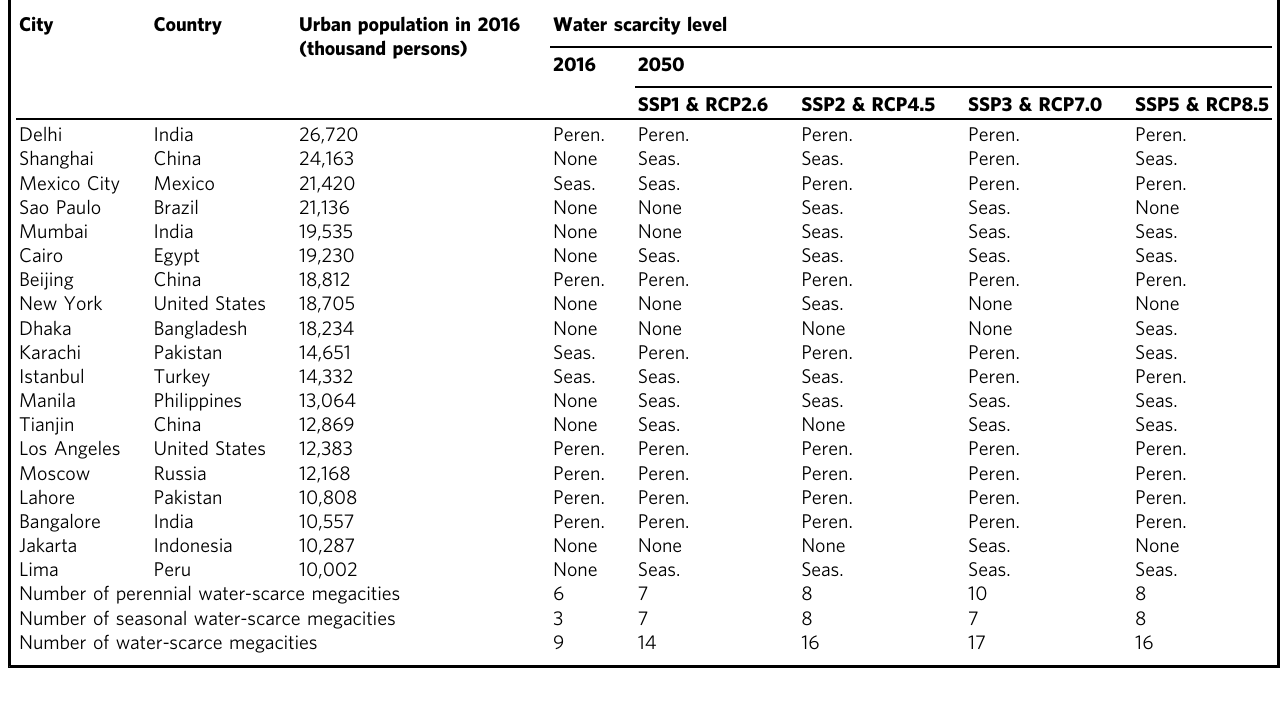
Table 2 Megacities facing water scarcity from 2016 to 2050.